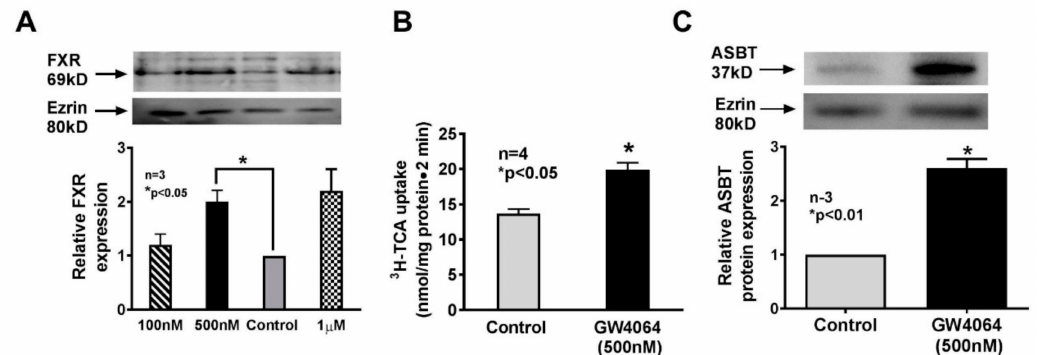
Figure 7. E ff ect of FXR agonist on rat intestinal epithelial cells (IEC-18) in vitro. ( A ) FXR agonist dose response e ff ect on FXR expression in IEC-18 cells. 500 nM appeared to be the ideal dose of the agonist, which was used in all subsequent studies. ( B ) FXR agonist stimulated Na-dependent bile acid uptake